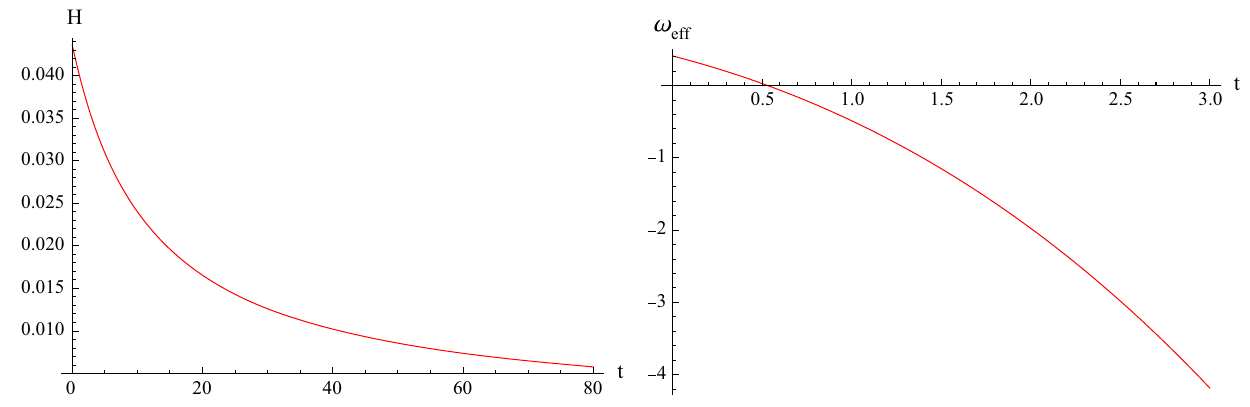
= 0 . 24, c (cid:4) = 0 . 45 and c (cid:4) = 5 . 5 1 2 3